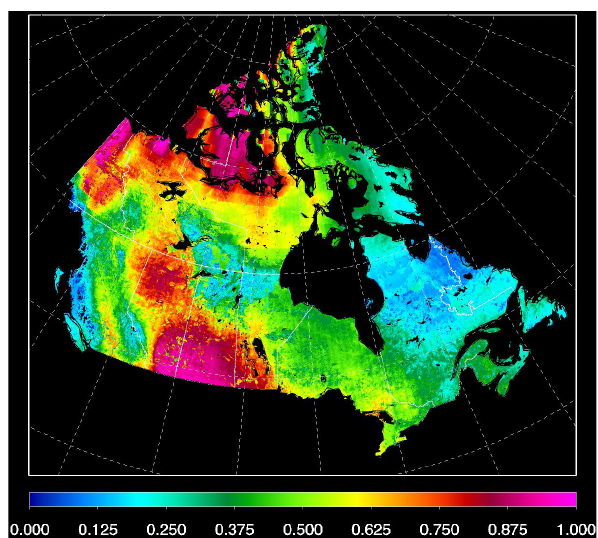
Fig. 11. Spatial distribution of the ratio of annual evapotranspiration to precipitation over Canada’s landmass averaged over 1979–2008.